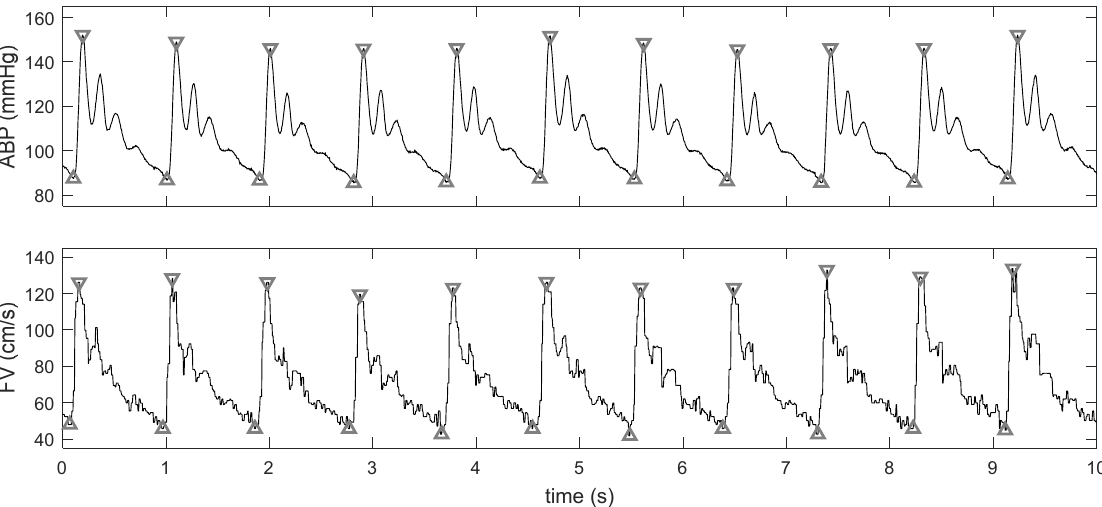
Figure 2. Detection of cardiac cycle: maximal (peak-systolic) and minimal (end-diastolic) values marked with triangles. Representative cycles were normalised so as for ABP and FV to assume values between 0 and 1 (see Figure 3). Three variants of calculating dissimilarity between ABP and FV waveforms, the latter referenced as Difference Index (DI), were proposed: = (cid:104) ABP − (cid:104) FV (cid:105) (cid:105) DI dif = (cid:104) ABP t − FV t (cid:105) ,DI abs = (cid:104)| ABP t − FV t |(cid:105) t t t t t